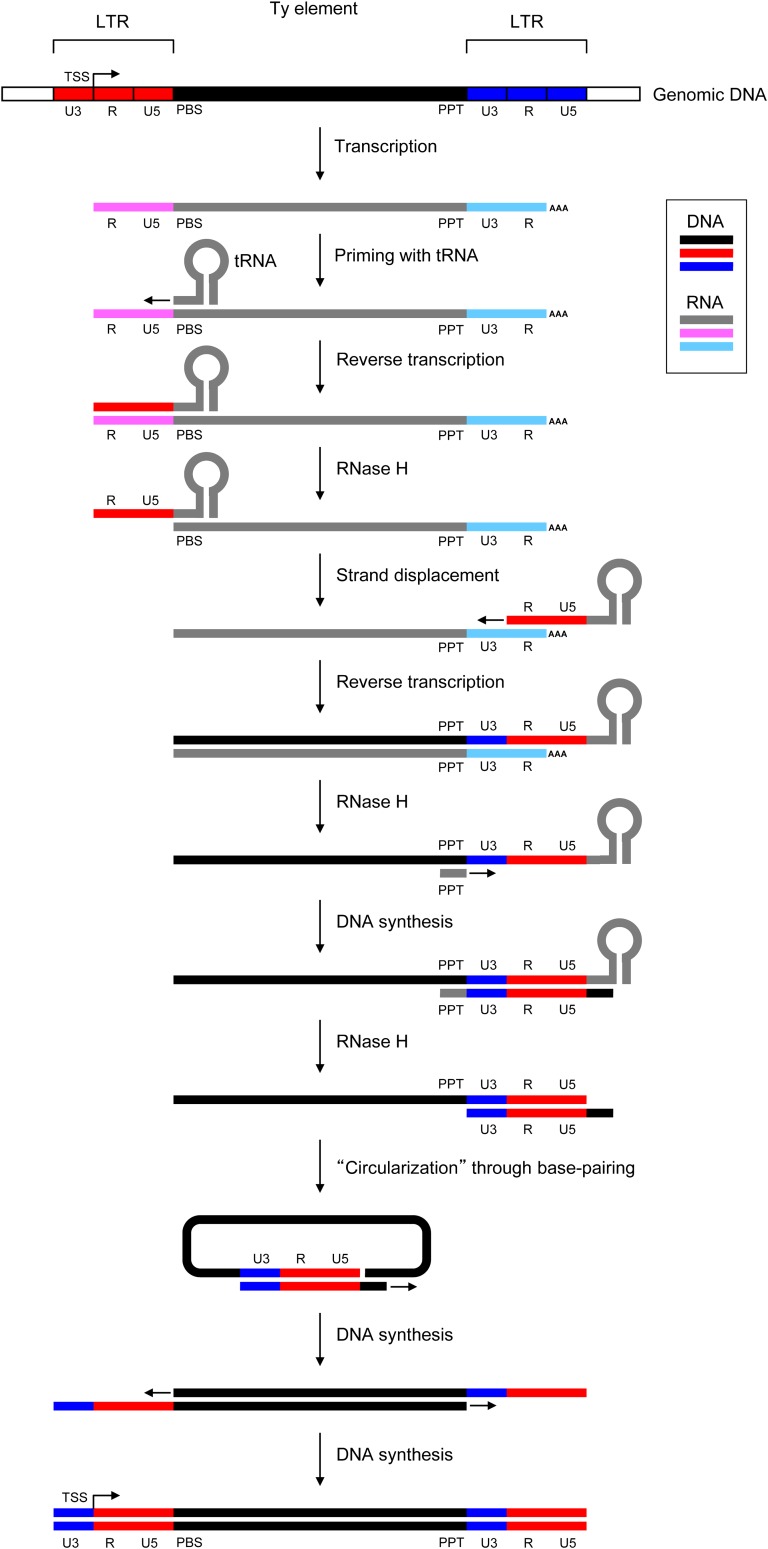
Overview of the life cycle of an LTR retrotransposable element. The transcription of a Ty element is followed by priming with tRNA, reverse transcription leading to a transcribed U5-R region (red), formation of single-stranded DNA by RNase H and strand displacement. Upon a second round of reverse transcription, a U3 region is generated from the 3′ LTR (blue). After additional steps by RNase H and subsequent DNA synthesis, a circular intermediate primes the final DNA synthesis of the Ty element through base-pairing, and the DNA circle reopens for final completion of the linear transposable Ty element by DNA synthesis. The figure is adopted and modified from Telesnitsky and Goff (1997).